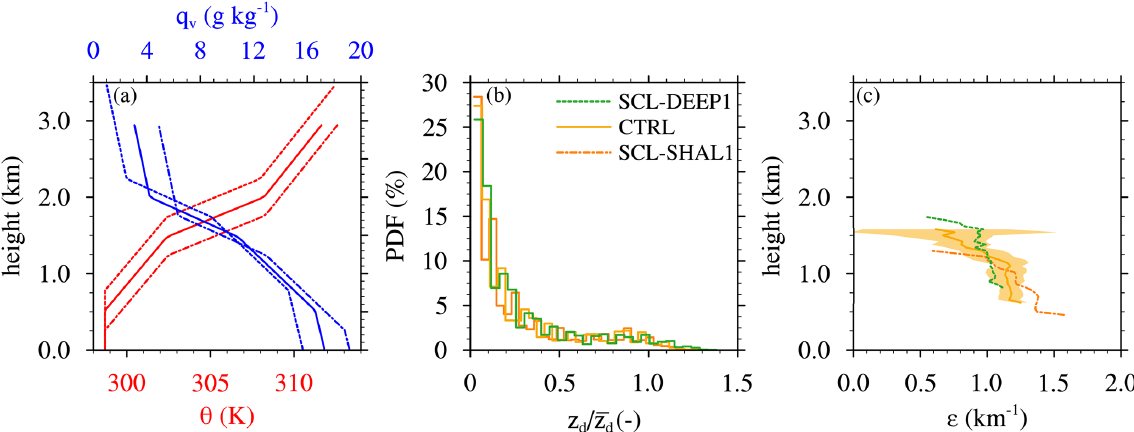
Figure 8. Same as Fig. 6 but for subcloud-layer depth